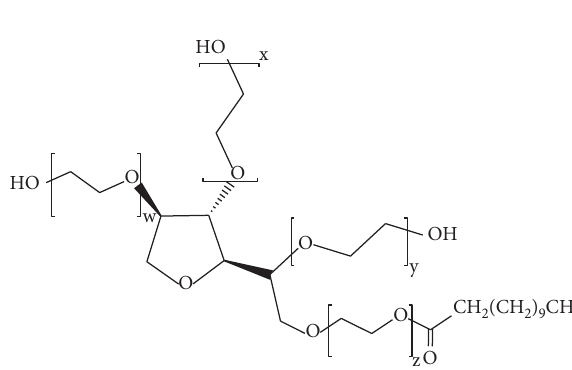
Figure 4: Chemical structure of Tween